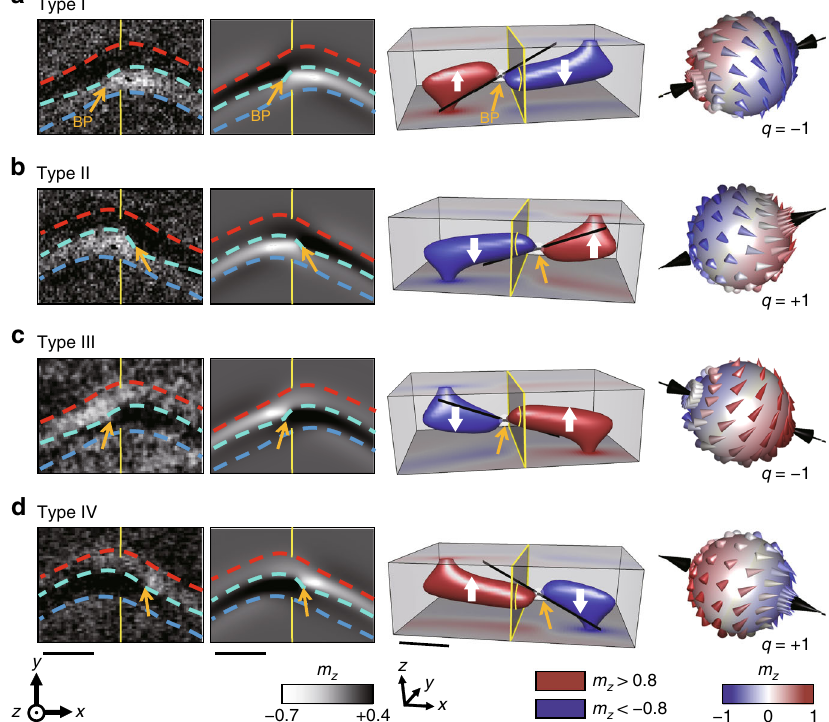
Fig. 2 Different types of single-Bloch point (BP) core structures. a – d Single-BP core structures with different magnetic con fi gurations, referred to as type I ( a ), type II ( b ), type III ( c ), and type IV ( d ). The zoomed-in magnetic transmission soft X-ray microscopy (MTXM) images for BP core structures together with simulated images are shown in the fi rst and the second columns (scale bars: 150 nm), respectively. The boundaries between the black and white contrasts are outlined by the red, turquoise, and blue dotted lines. The simulated internal structures are shown in the third column (scale bar: 50 nm), and the con fi gurations of the BPs contained in the vortex core structures are shown in the fourth column. The yellow line outline the central plane in the disk. The categorization is based on the polarizations of the cores on the top surface and bottom surface of the disk, volumes of cores, and the location of the